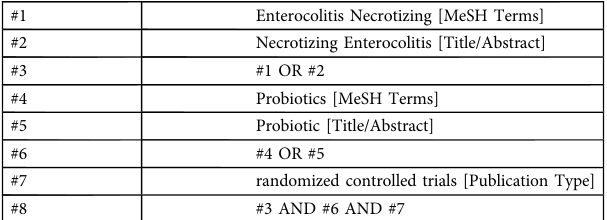
TABLE 1 Search strategy on